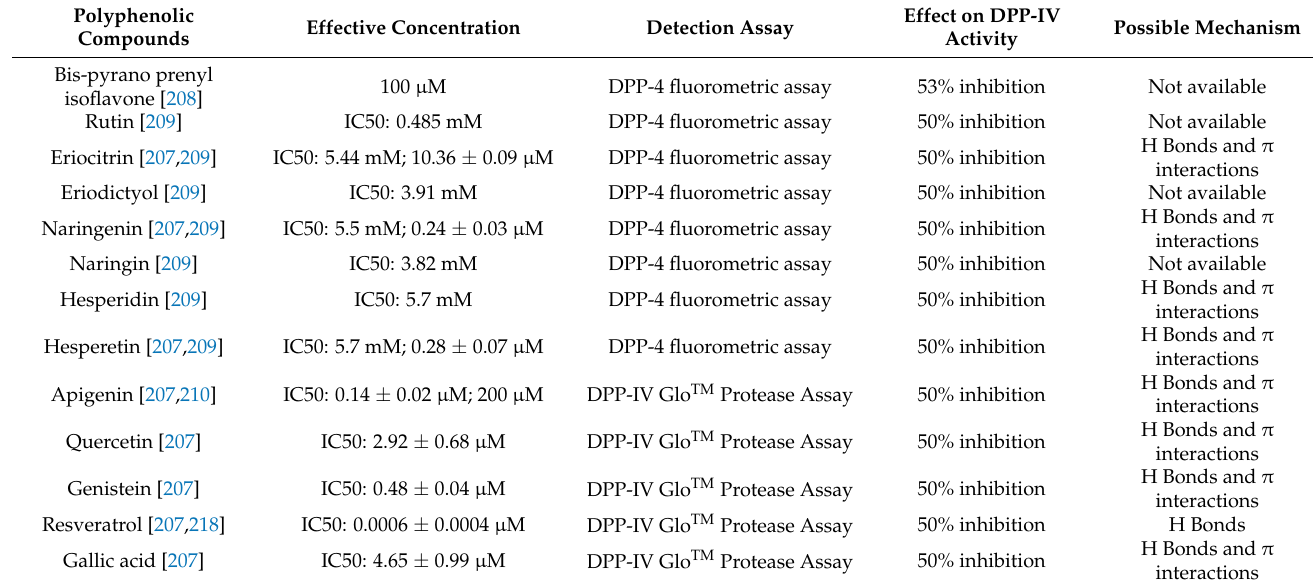
Table 3. Polyphenols regulates dipeptidyl peptidase IV (DPP-IV)